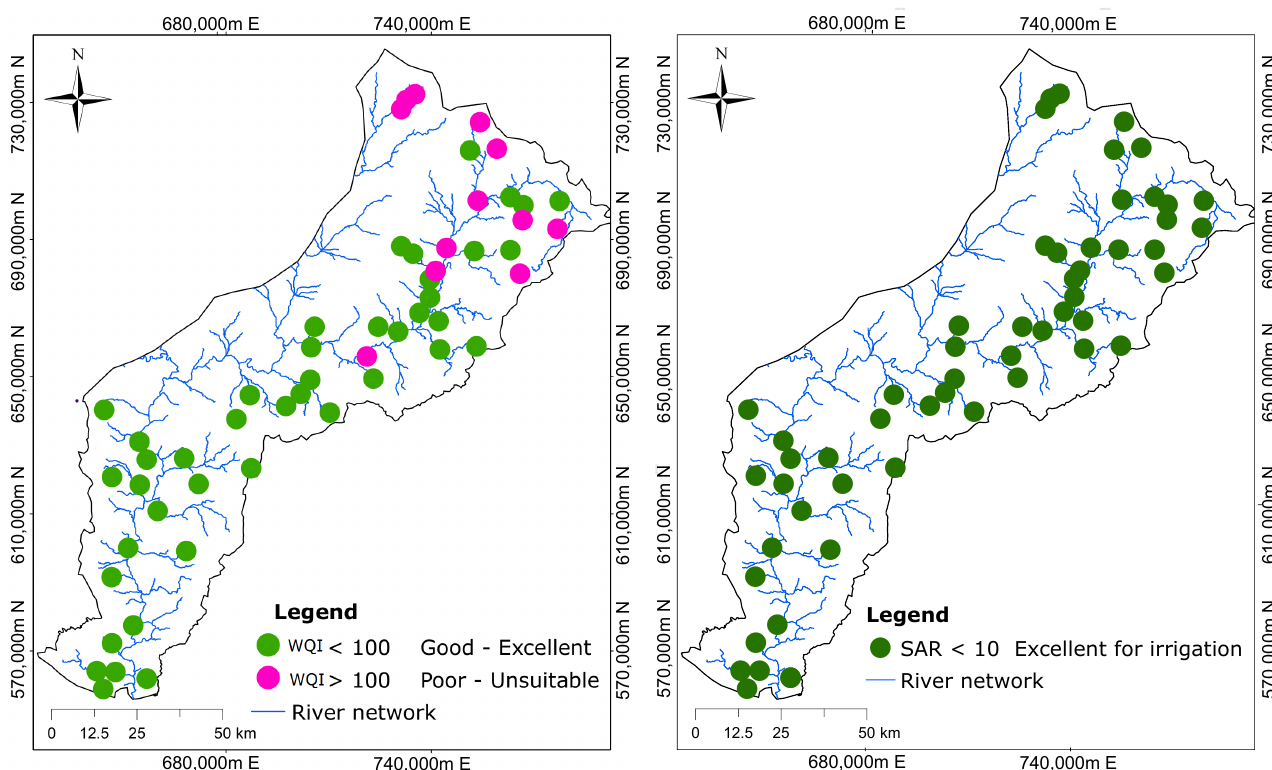
Figure 6. Groundwater spatial distribution maps of ( a ) Water Quality Index (WQI) and ( b ) Sodium Adsorption Ratio (SAR) for the assessment of water quality for drinking and irrigation